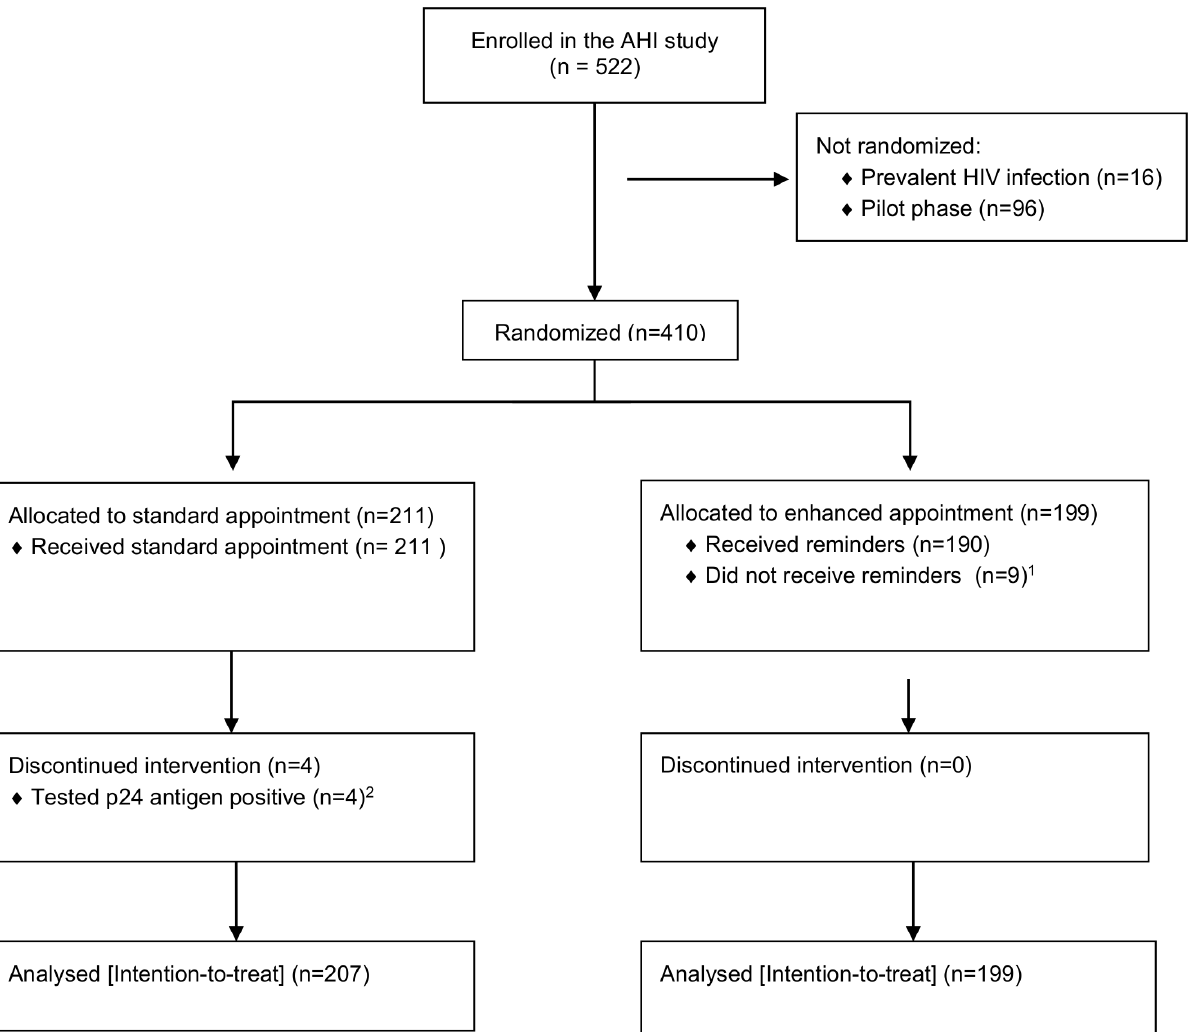
Fig 1. Flow of participants. 1 Reminders were not sent because locator forms were missing. 2 Participants who tested p24 antigen positive were recalled to the clinic immediately, hence not included in the analysis of intervention